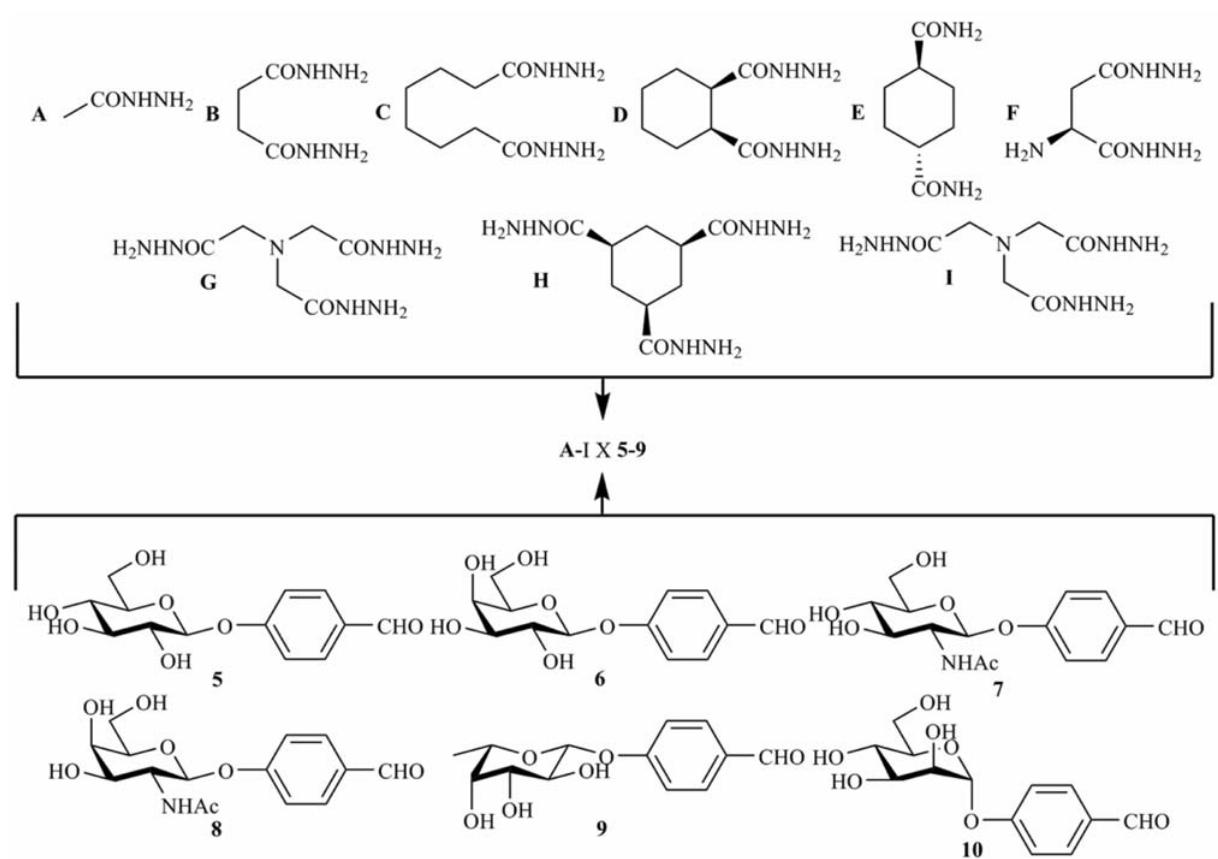
Figure 2. A series of oligohydrazide A – I and aldehyde building blocks 5 – 10 generating an acylhydrazone dynamic combinatorial library of poten- tial plant lectin Con A inhibitors.